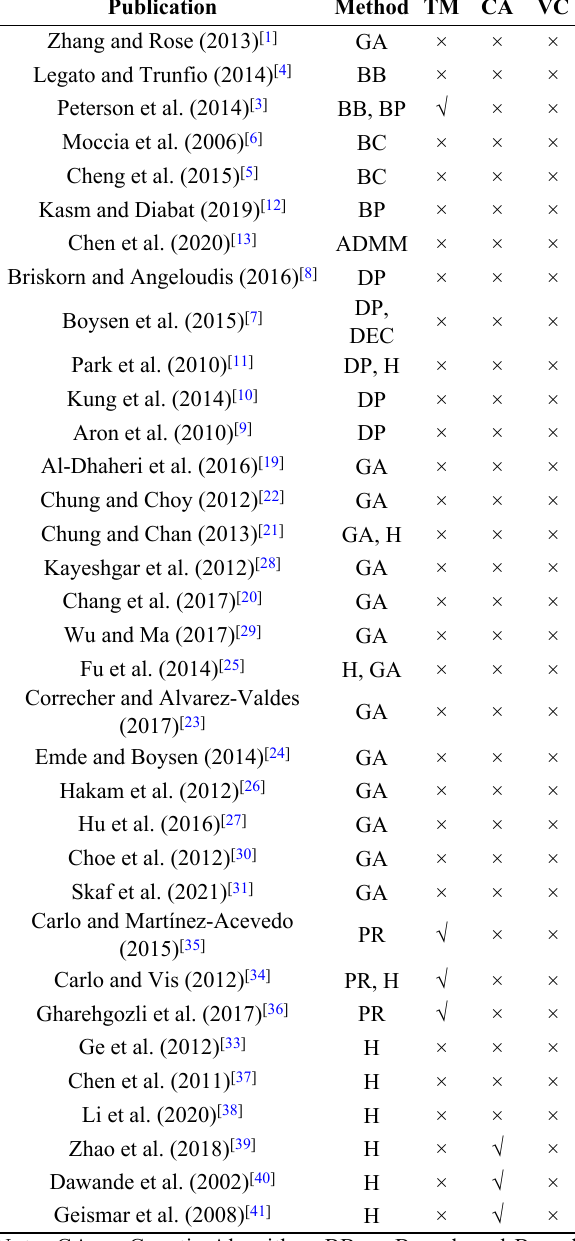
Table 1 Overview of studies considering crane